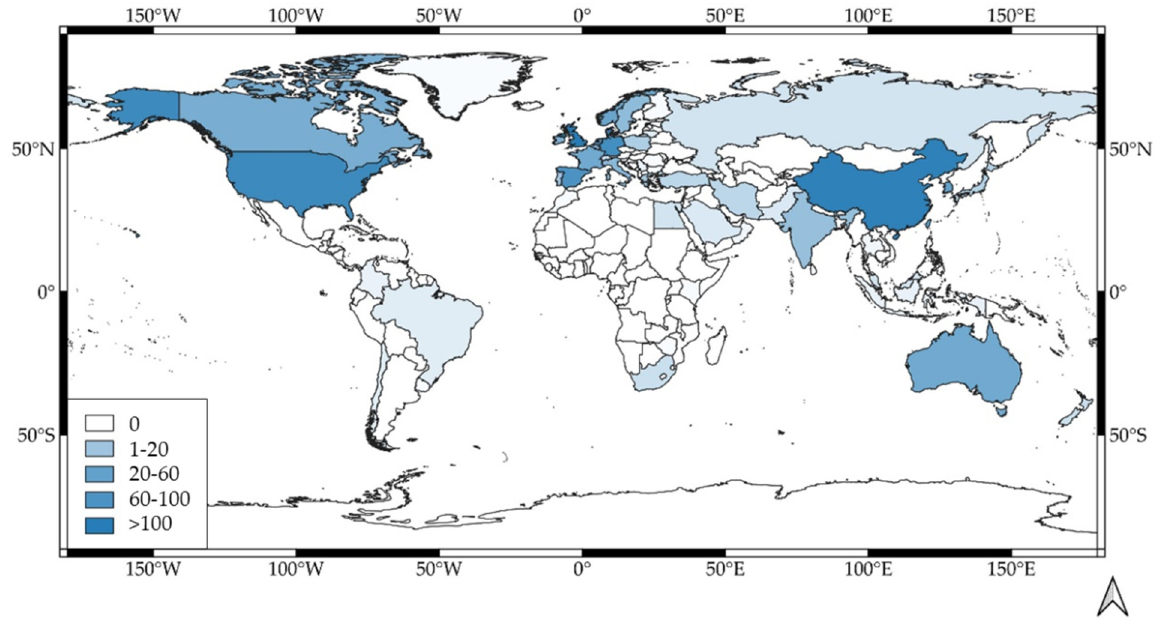
Figure 3. A map showing the countries that published WOS papers related to offshore wind